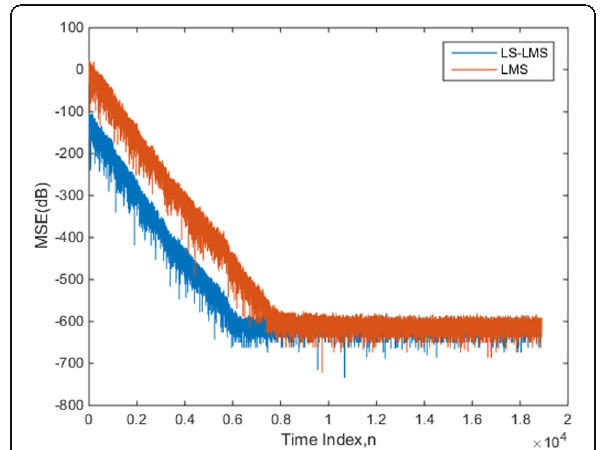
Fig. 6 The MSE learning curves